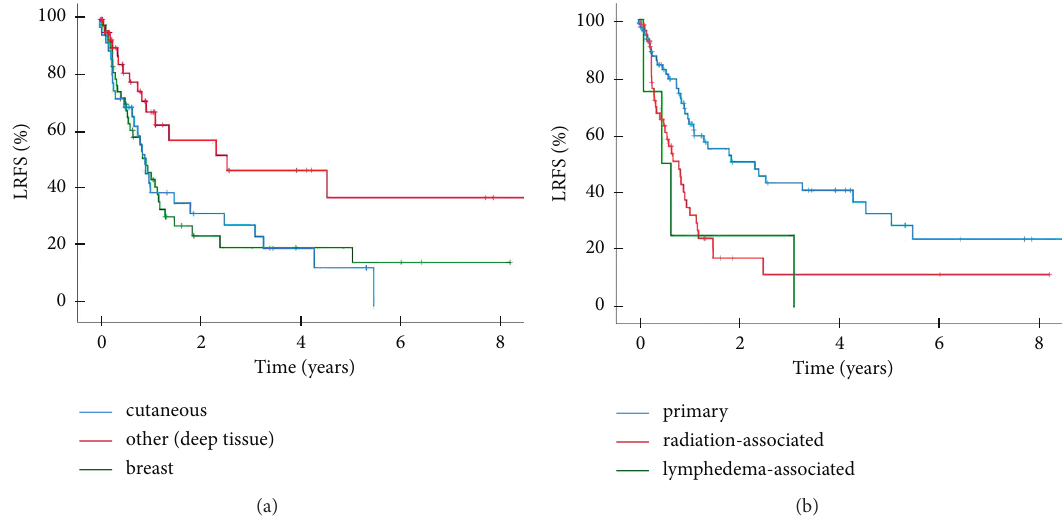
Figure 2: Local recurrence-free survival (LRFS). Kaplan–Meier curves showing 8-year LRFS (a) comparing deep soft tissue angiosarcomas ( N � 47), cutaneous angiosarcomas ( N � 37), and angiosarcomas of the breast ( N � 52) with a median LRFS of 30.2 vs. 10.7 vs. 11.0 months ( p � 0.013 ∗ ; p � 0.018 ∗ ) and (b) comparing primary ( N � 77), radiation-associated ( N � 45), and lymphedema- associated ( N � 4) angiosarcomas with a median LRFS of 27.6 vs. 9.6 vs. 5.5 months ( p � 0.001 ∗∗∗ ; p � n.a.).